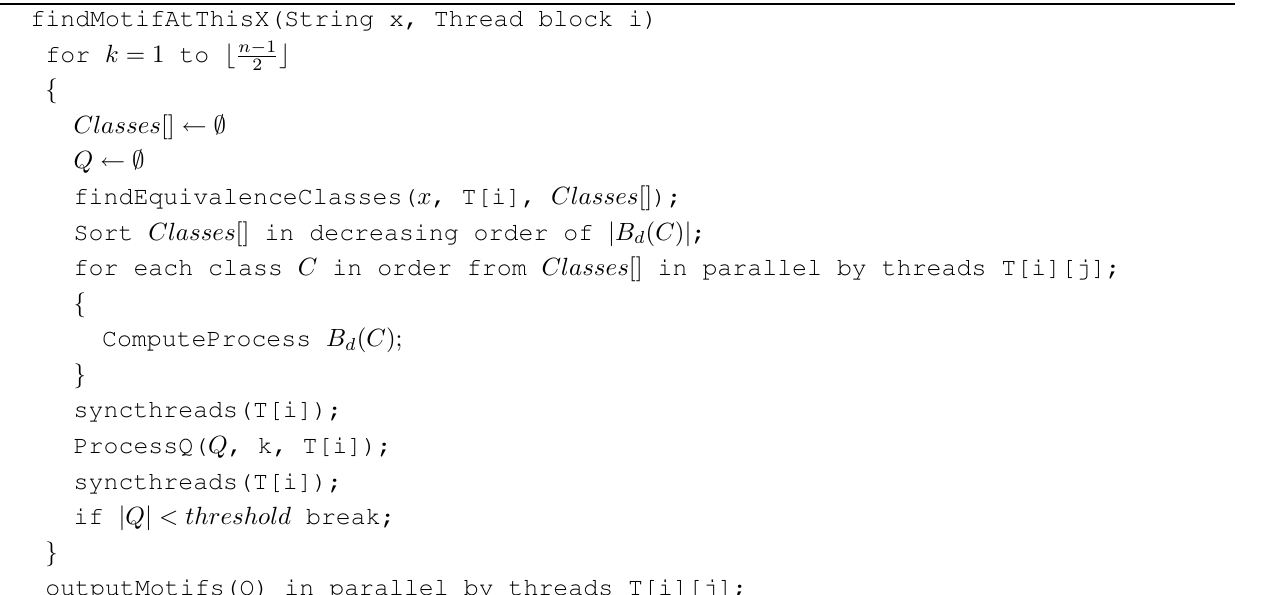
Algorithm 4: Finding motifs in parallel.